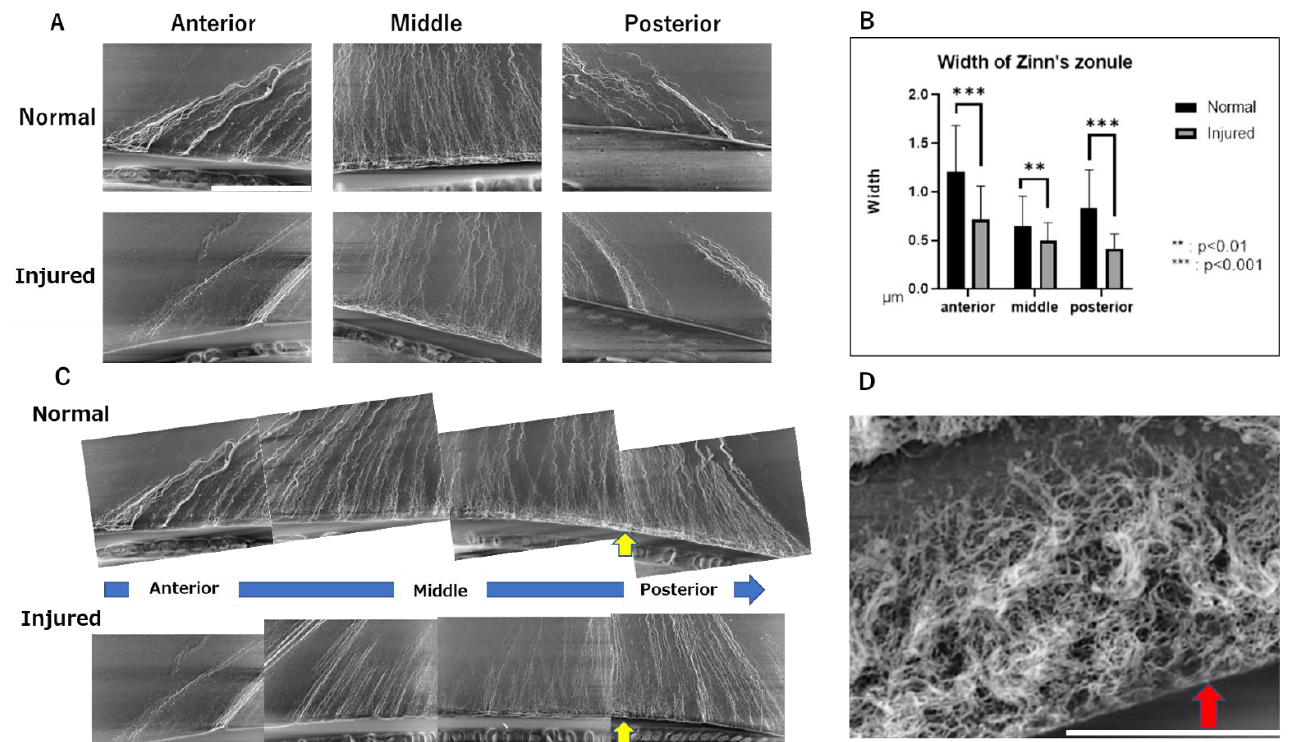
Figure 5. Ultrastructural observations of Zinn’s zonules labeled with anti-MAGP1 antibody using LV-SEM. ( A ) Observations of Zinn’s zonule were made at 1500× magnification with LV-SEM to evaluate changes near the lens. Zinn’s zonule was observed in the anterior and posterior branches and in their center. Scale bar: 50 μm. ( B ) The width of Zinn’s zonule was measured in 10 random locations on each slide. Compared to the normal group, Zinn’s zonule is significantly thinner in all locations in the injured group. The anterior and posterior cecal branches show even more significant differences. ( C ) Each of the 1500×-magnified images was composited as a series and observed. On the lens capsule in the area noted by the yellow arrow, a structure not observed in the anterior capsule branch attachment area is observed. This is thought to be the fibrillar girdle. ( D ): Observations of Zinn’s zonule were made at 8000× magnification with LV-SEM. The red arrow indicates a mesh structure on the lens capsule that is thought to be a fibrillar girdle. Scale bar: 10 μm. Four specimens were used for the normal and injured groups and three 5 μm sections were made from each specimen. We observed Zinn’s zonule in two locations of each section. LV-SEM: low-vacuum scanning electron microscopy.